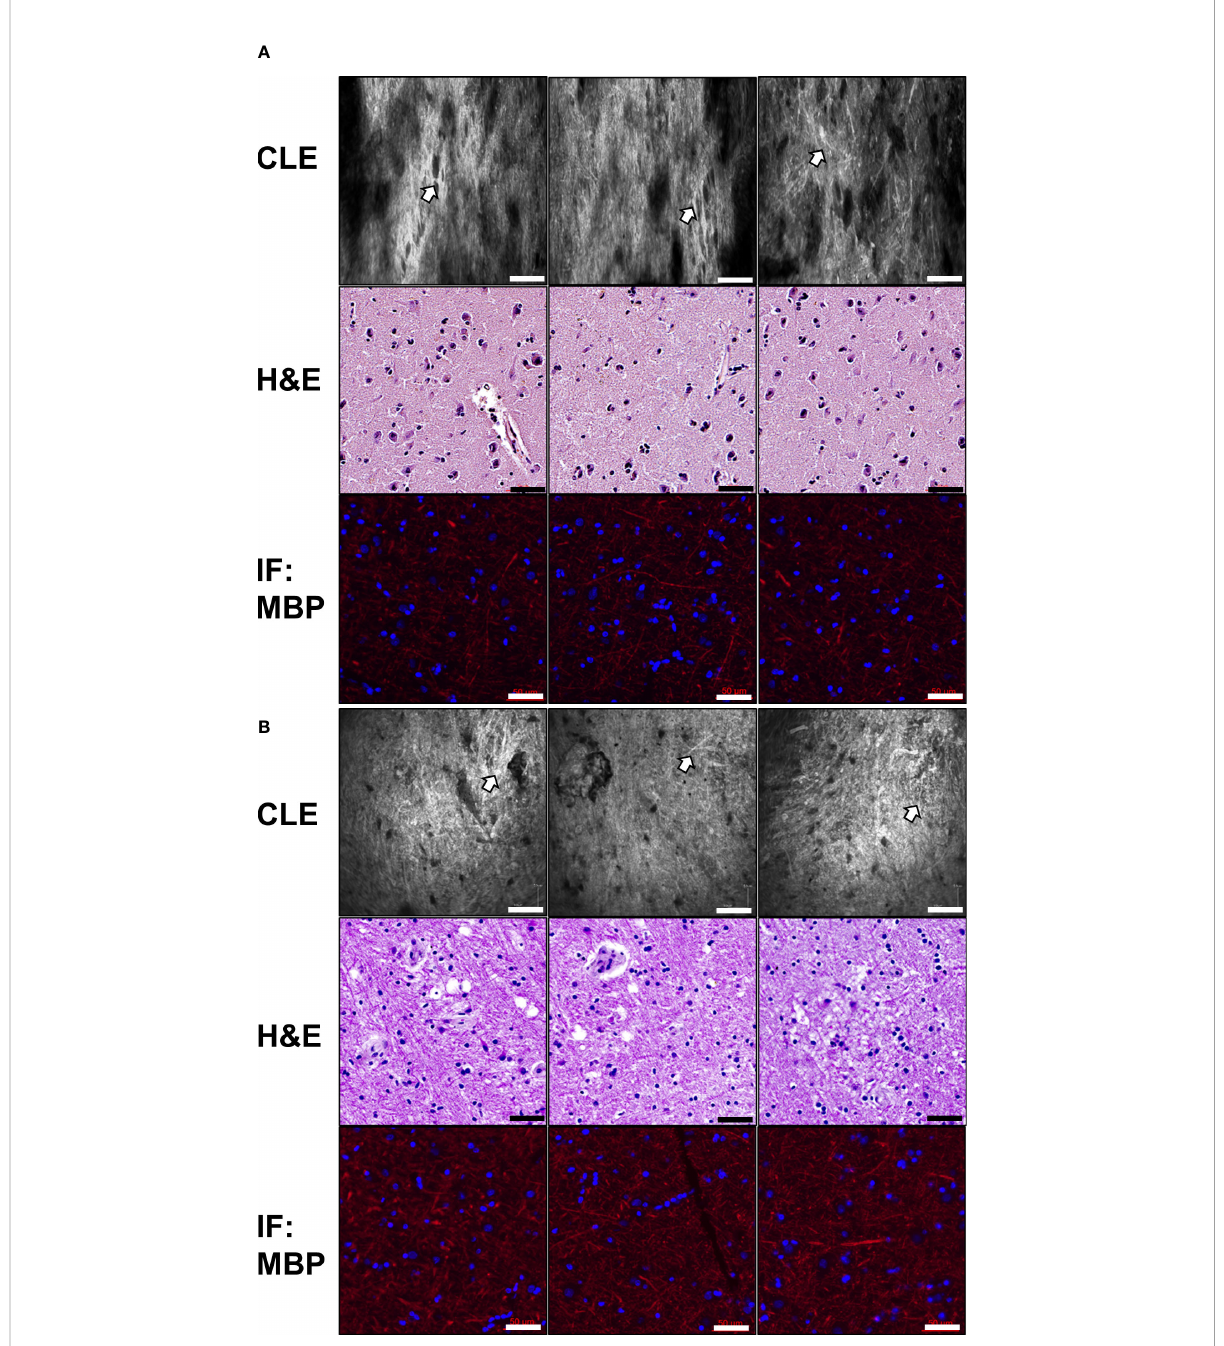
FIGURE 4 Representative images of normal human brain tissues Normal brain tissues were obtained from the cerebral cortex (A) and subcortical areas (B) during surgical resection. CLE images show a dense streak-like pattern throughout most of the brain mass (white arrows). H&E staining revealed the presence of large neuronal cells (A) and glial cells (B) . Myelin basic protein (MBP) immunostaining of the same tissue sample revealed dense axonal fi bers (red). Scale bar: 50 µm. H&E, hematoxylin and